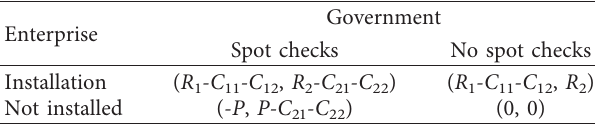
Table 4: The game utility matrix of automobile manufacturing enterprises and the government with regard to installing purifiers.